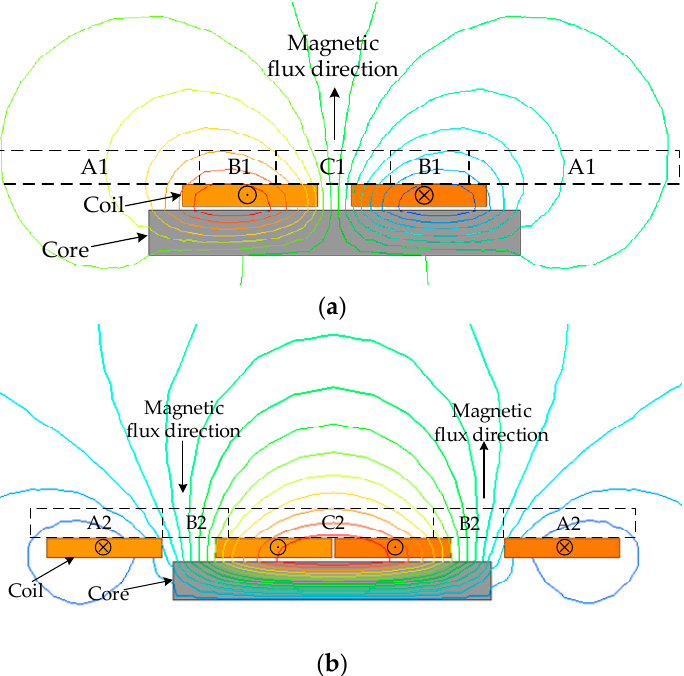
Figure 1. Planar single and bipolar emission magnetic field diagrams. ( a ) Unipolar magnetic field; ( b ) Bipolar magnetic field.